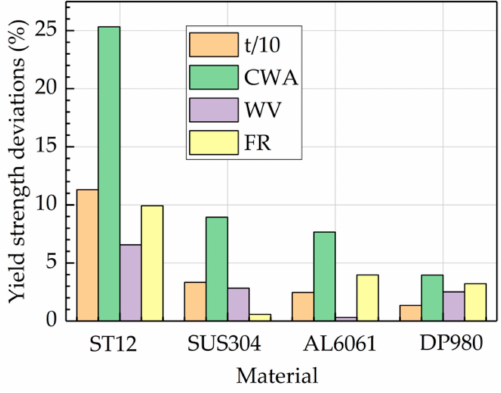
Figure 15. Deviation results of experimental